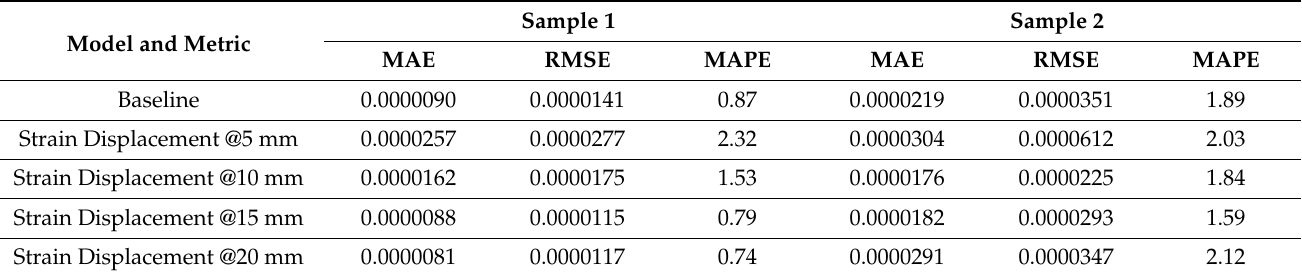
Table 5. Accuracy of proposed CNN-LSTM model for Sample 1,2.